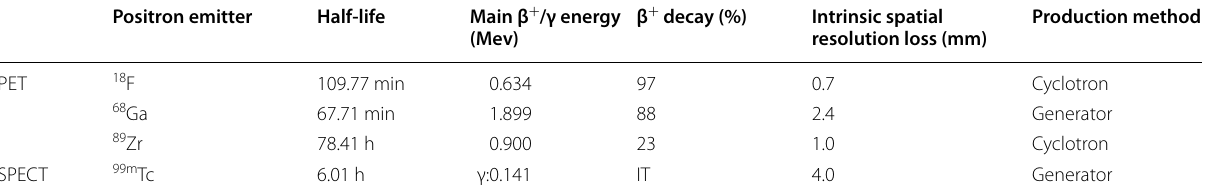
Table 2 Radioisotopes used for in vivo T-cell imaging/tracking and their physical characteristics